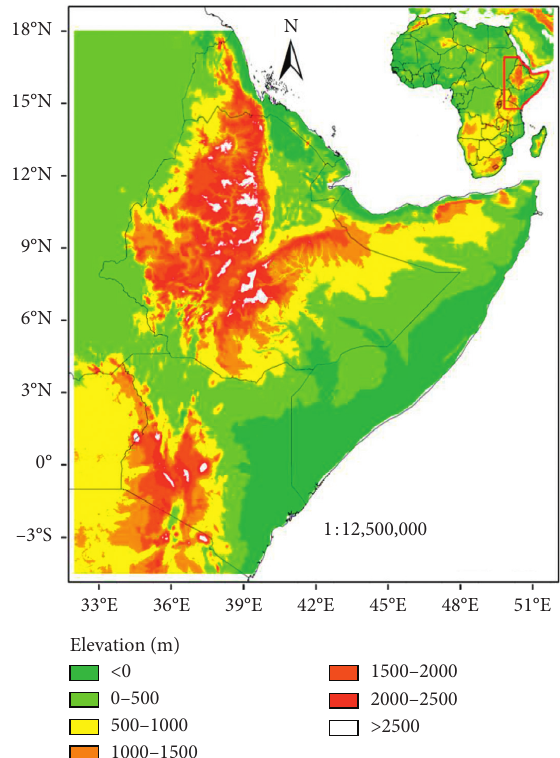
Figure 1: The study domain (4.5 ° S–18 ° N, 32 ° –51.5 ° E) and its to- pographic elevation